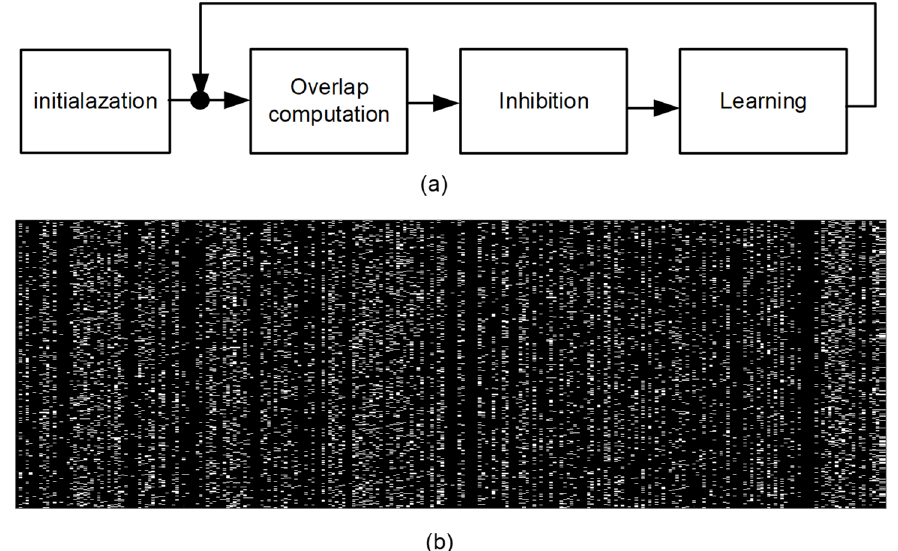
Figure 4. ( a ) The spatial-pooling algorithm composed of initialization, overlap computation, inhibition, and learning [8,12]; and ( b ) the defect map of a memristor crossbar with 10% random defects. Here the numbers of rows and columns of the crossbar are 400 and 256, respectively. The random defects are stuck-at-LRS and stuck-HRS defects.